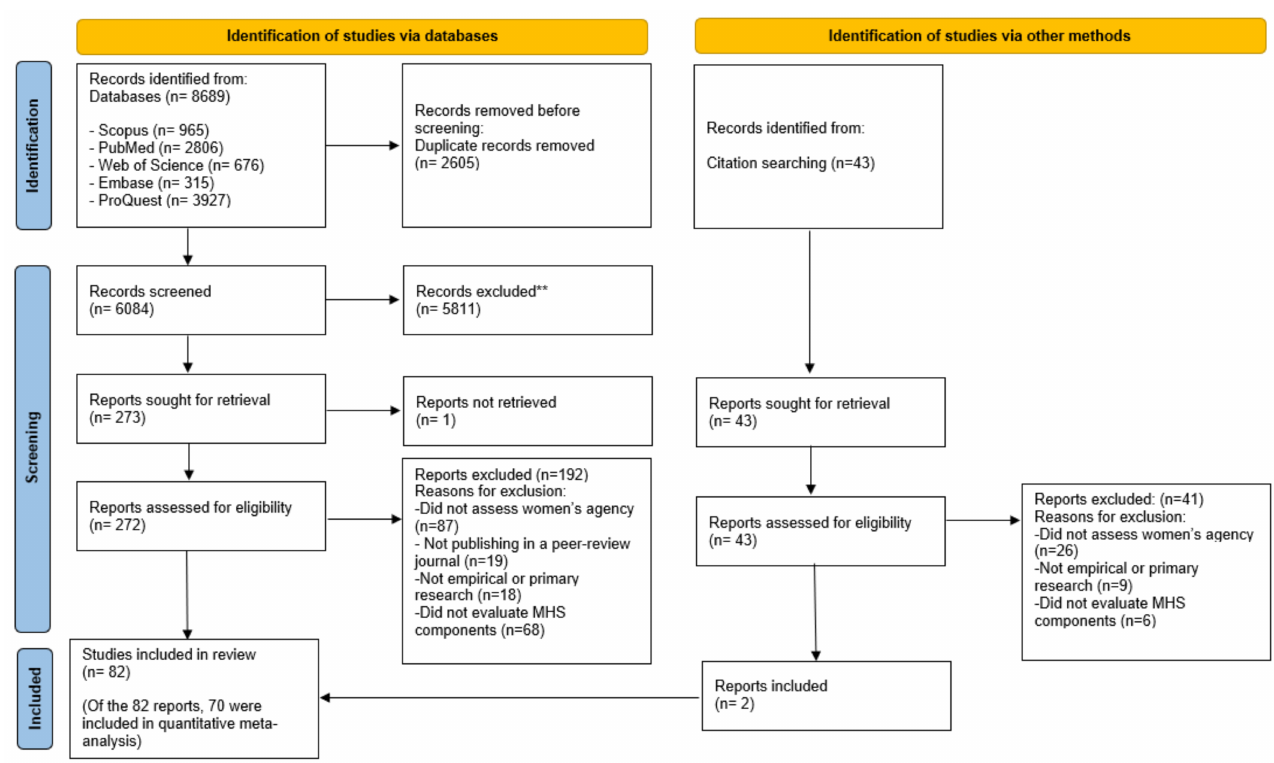
Figure 1. PRISMA flow diagram of searching and selection process.